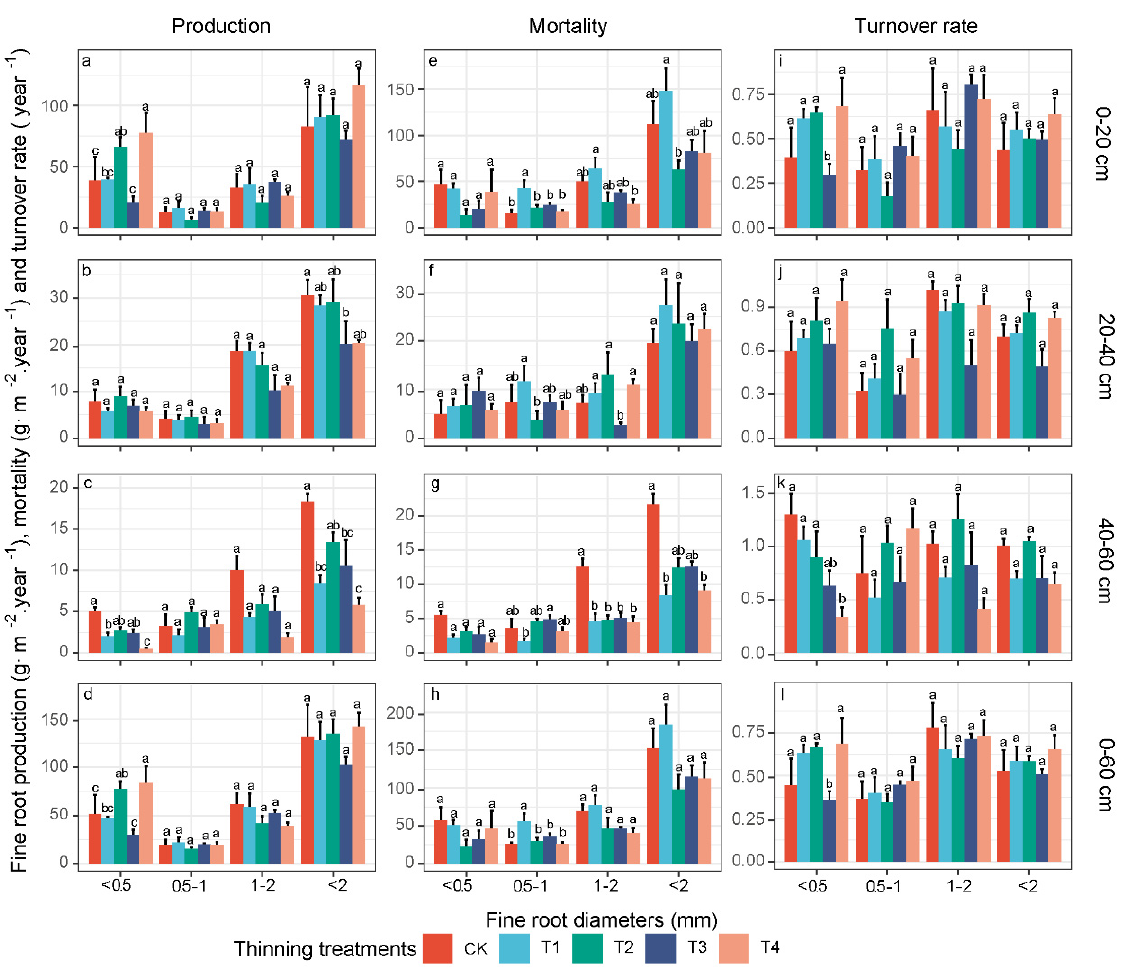
Figure 4. The effects of the thinning intensities on the fine-root production, mortality and turnover rate among different diameter classes at different soil depths ( a – c , e – g , i – k ), and the entire soil profile ( d , h , l ). The values are the mean of four replicates ± SE. CK, T1, T2, T3, and T4 represent 0%, 15%, 30%, 45% and 60% thinning intensities, respectively. Different lowercase letters (a, b, c, d) indicate significant differences for the same diameter class of fine roots among the thinning intensities ( p < 0.05). Table 5. The effects of the thinning intensity (T) on the annual production, mortality, and turnover rate of fine roots over the entire soil profile, and at specific depths (D).